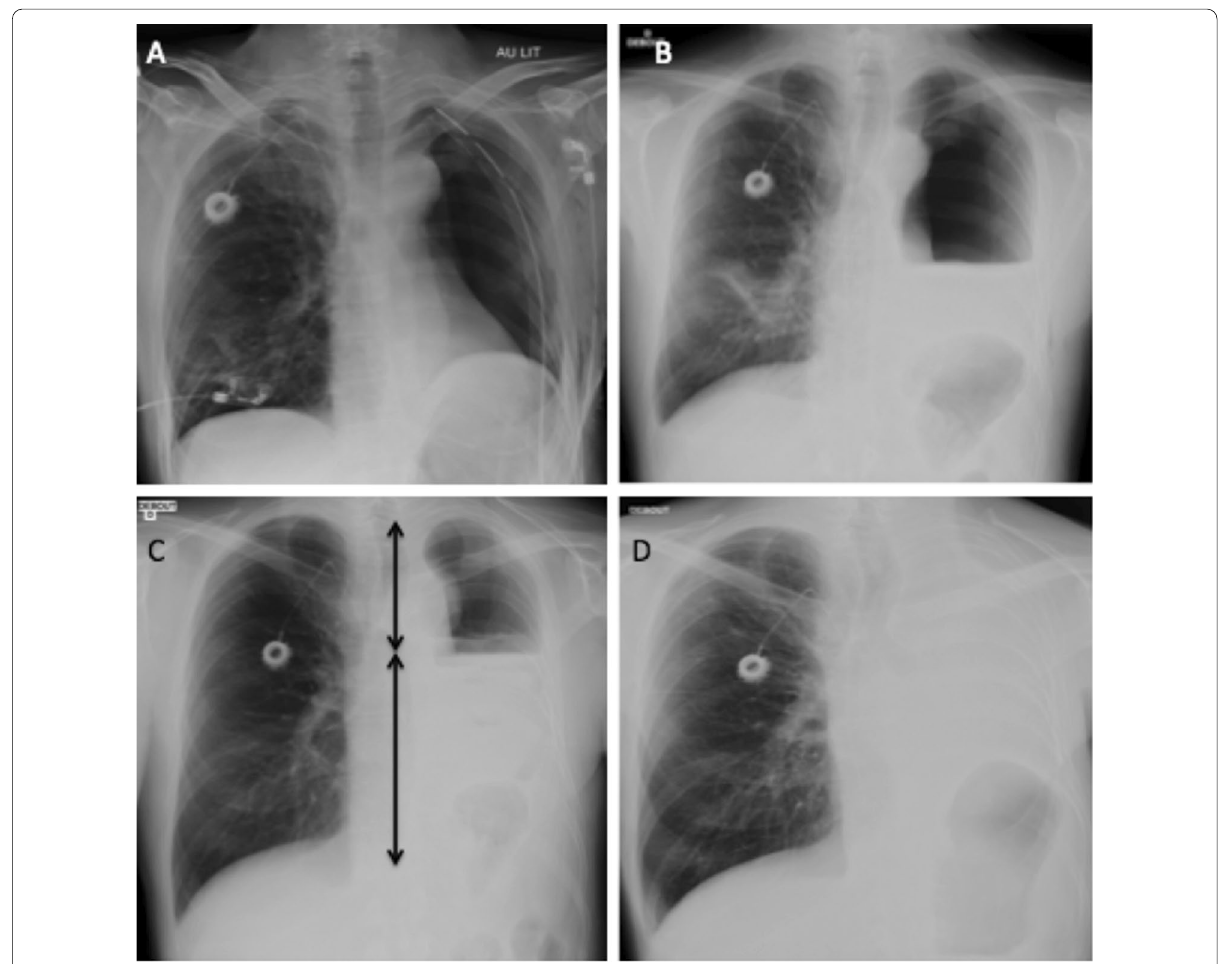
Fig. 5 Pneumonectomy cavity evolution. A : First post‑operative CXR in the hours following left pneumonectomy, with a chest tube in antero‑apical position. B : Day 3 CXR with progressive filling of the pneumonectomy cavity. C : Day 7 CXR on which you can see that the air–fluid level reaches two‑thirds of the pneumonectomy cavity. D : CXR after 2 months showing a complete filling of the cavity